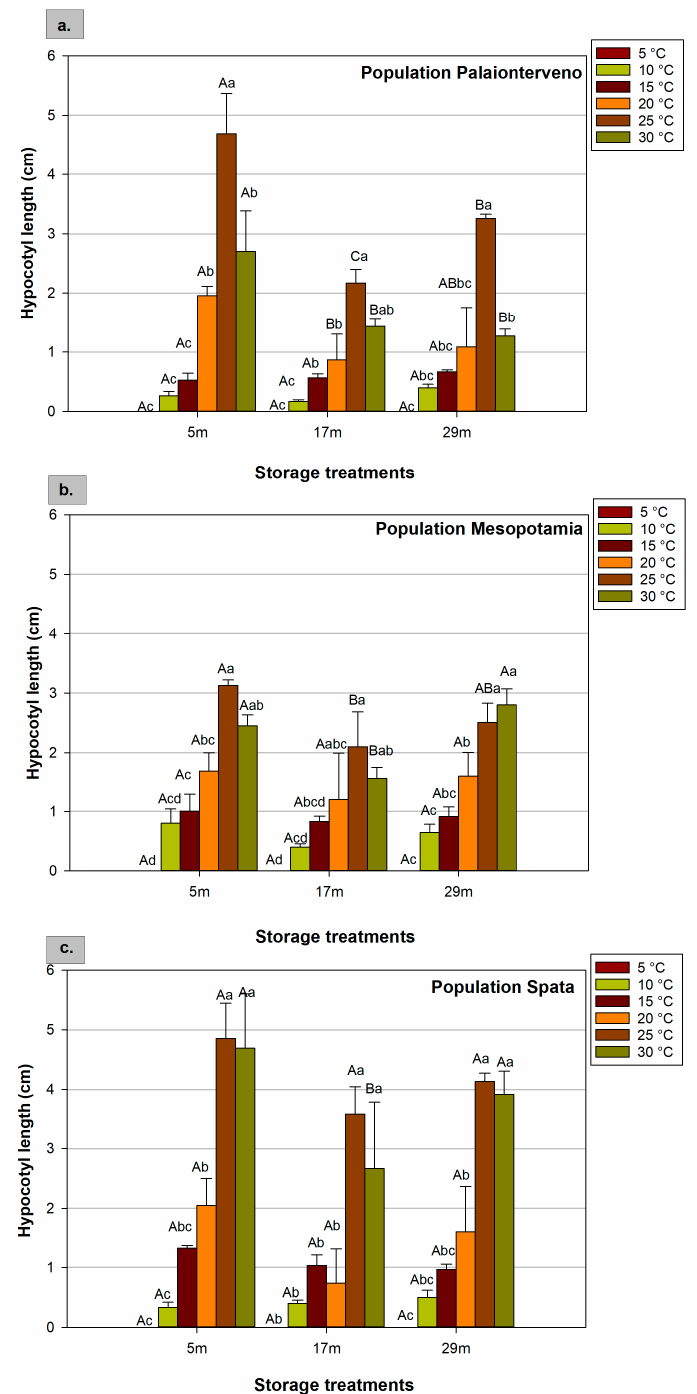
Figure 5. Effect of population (( a ) Palaionterveno, ( b ) Mesopotamia, and ( c ) Spata), storage (duration and conditions: 5, 17, and 29 refer to the months (m) of storage and the conditions that prevailed during storage), and temperature (5 ◦ C, 10 ◦ C, 15 ◦ C, 20 ◦ C, 25 ◦ C, and 30 ◦ C) on hypocotyl length of milk thistle. Capital letters show significant differences between storage treatments at the same temperature, while small letters show significant differences between temperatures at the same storage treatment. The bars represent the standard error of the means.